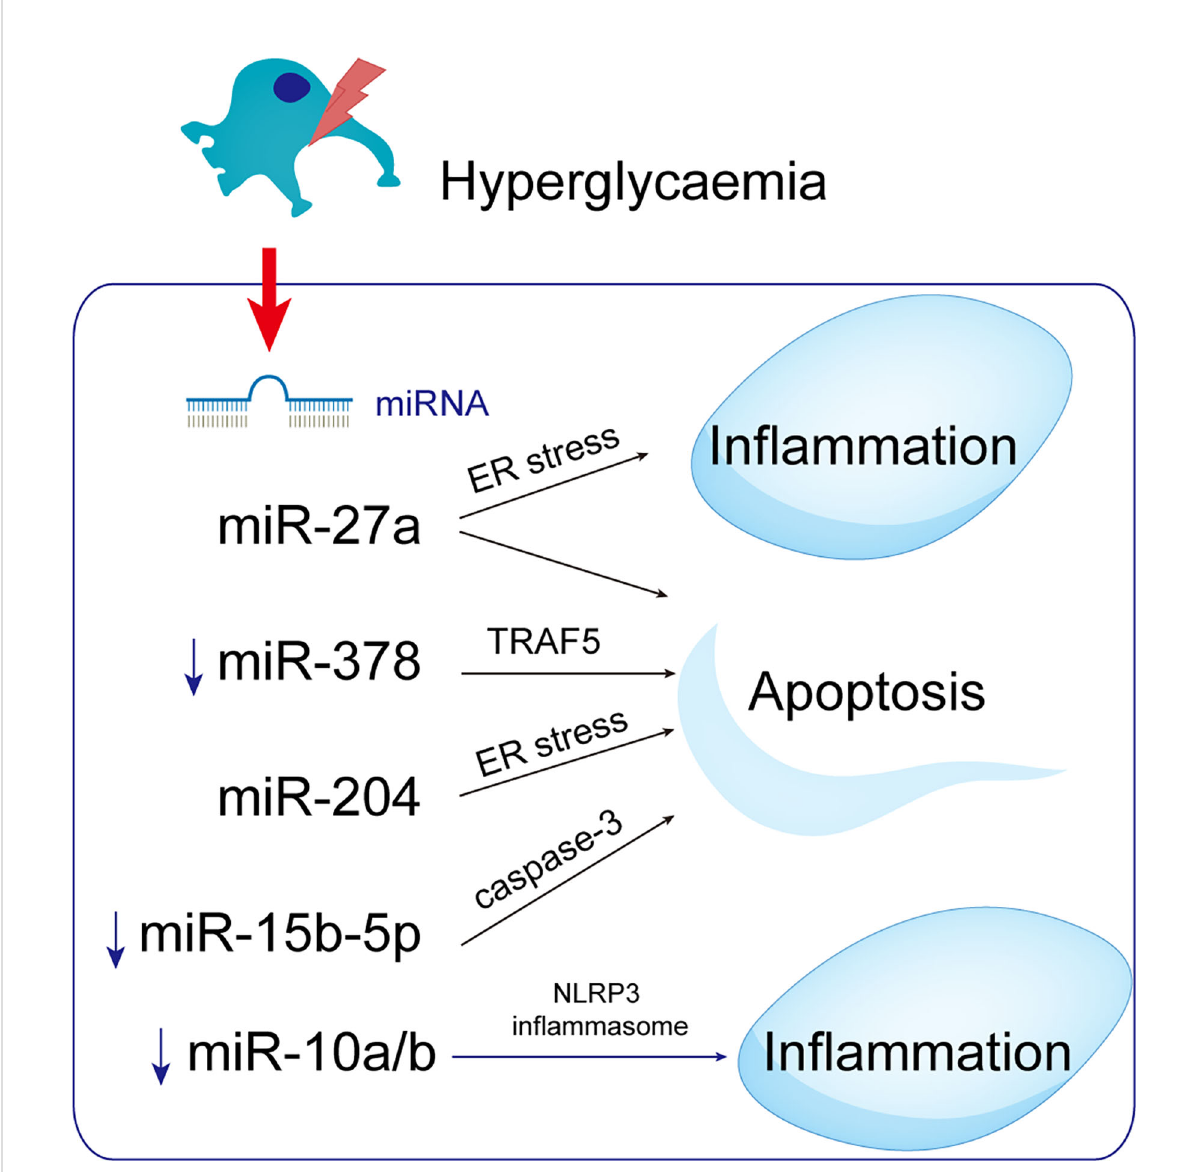
FIGURE 7 MicroRNAs with potential roles in podocytopathies. Hyperglycemia up- or down-regulates miRNAs in podocytes, resulting in podocytopathies. ↑ Indicate increased expression, ↓ Indicate